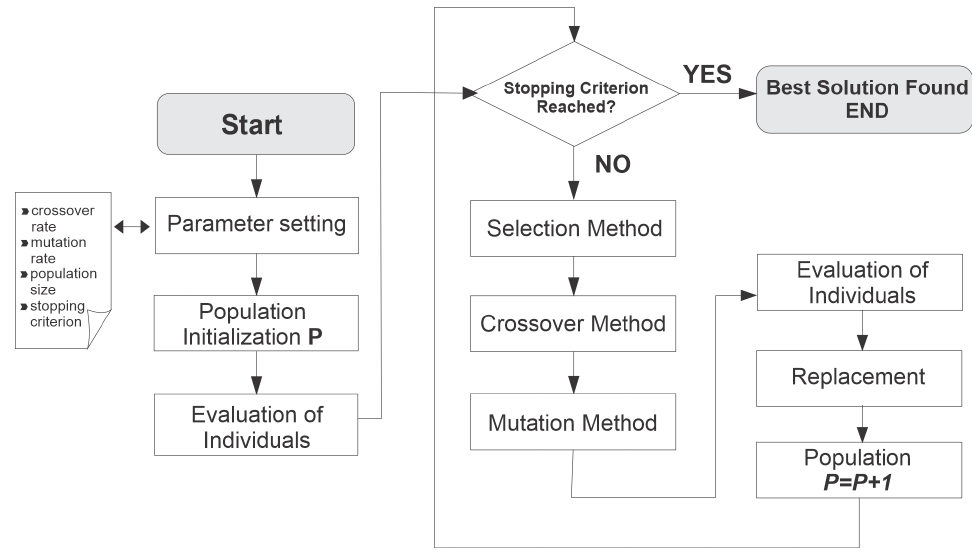
Figure 2. The standard workflow of Genetic Algorithm